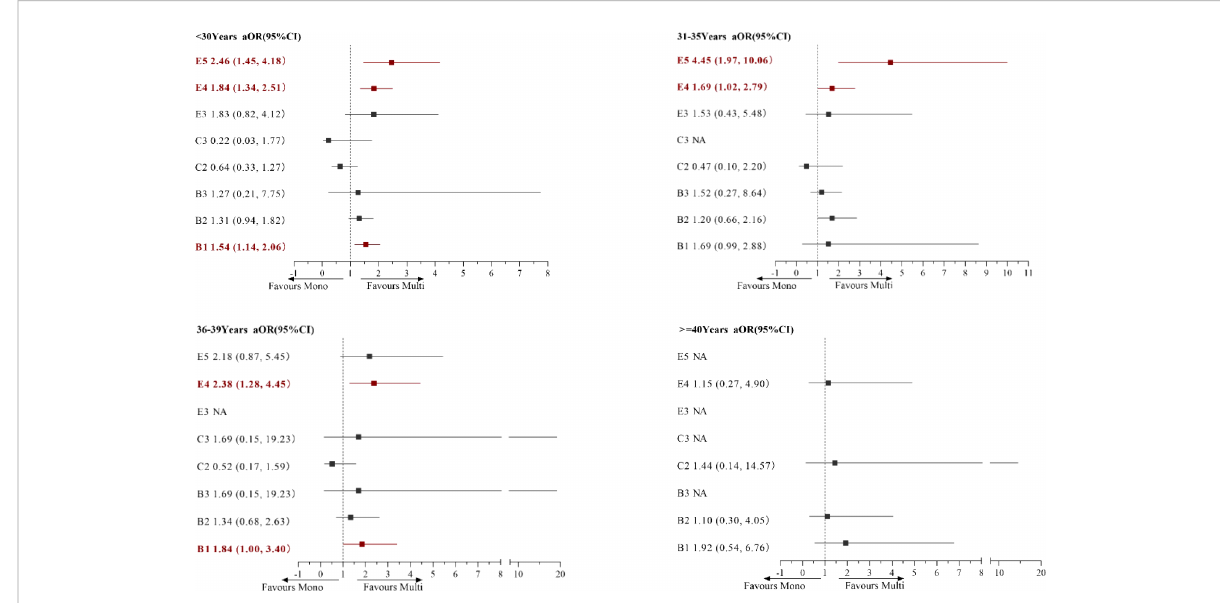
FIGURE 1 Logistic regression analysis for multiple birth rate (MBR) among patients based on age and embryo transfer group. *AOR: adjusted odds ratio for type of infertility, indications for IVF, body mass index (BMI), and anti-Müllerian hormone (AMH) in logistic regression